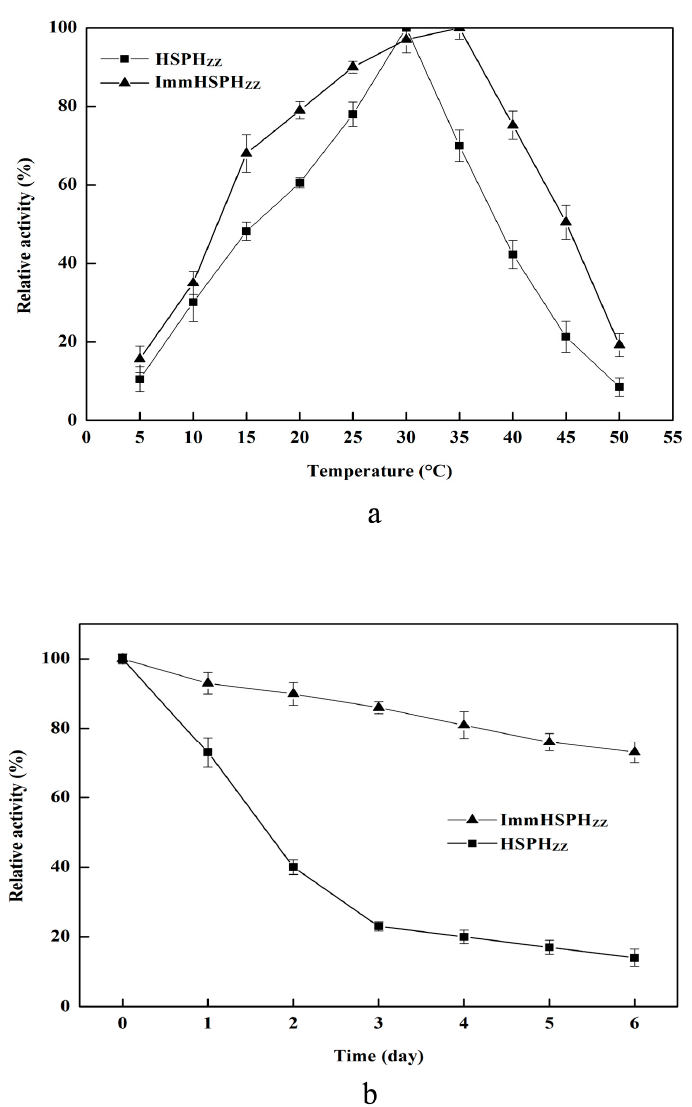
Figure 4. Temperature optima ( a ) and thermostability ( b ) of HSPH ZZ and ImmHSPH ZZ . ( a ) Temperature optimums of HSPH ZZ and ImmHSPH ZZ were determined with HSP as substrate in 20 mM Tris-HCl buffer (pH 9.0) at temperatures ranging from 5 to 50 ◦ C. ( b ) Thermostability of HSPH ZZ and ImmHSPH ZZ . The residual enzyme activity was measured after incubation of the enzyme at 40 ◦